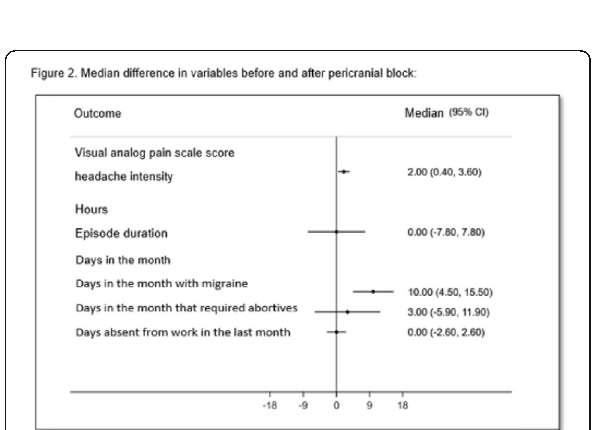
Fig. 2 (abstract P0461). See text for